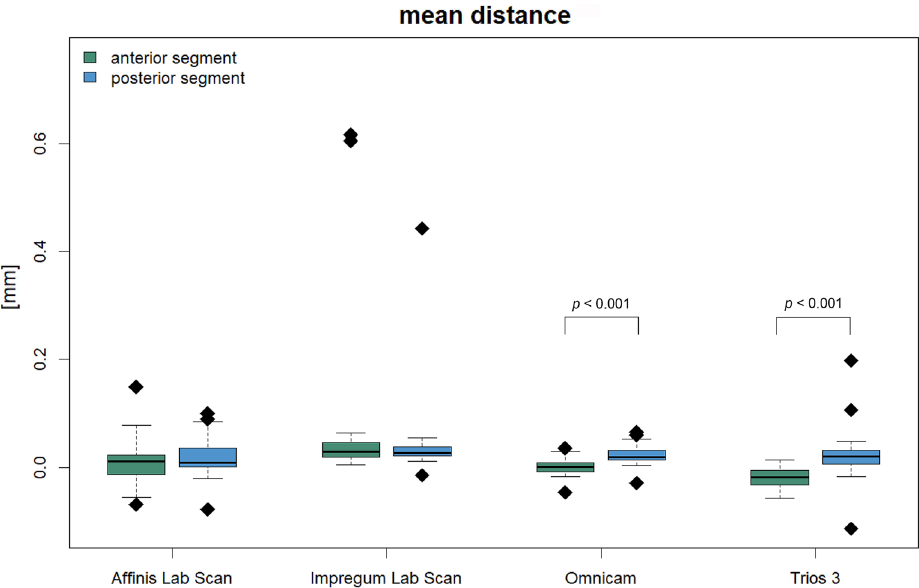
Figure 3. Mean distance for the anterior and posterior segment of dental arch (n = 31) and significant p